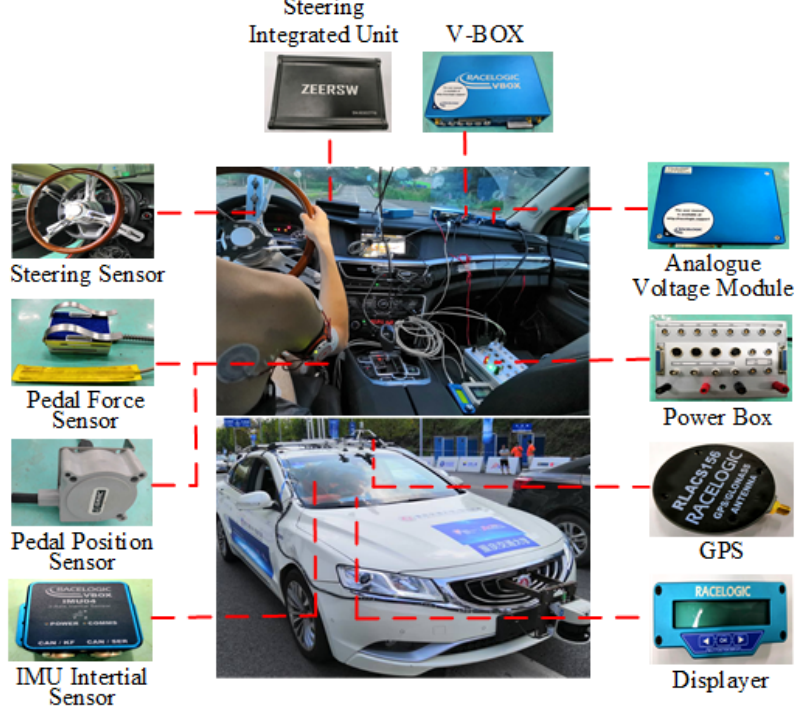
Figure 4. Field experimental facilities.